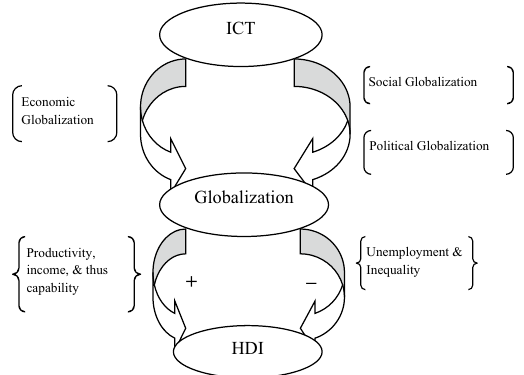
Fig. 3 Theoretical Interrelationship between the variables (Source: authors’ compilation from the